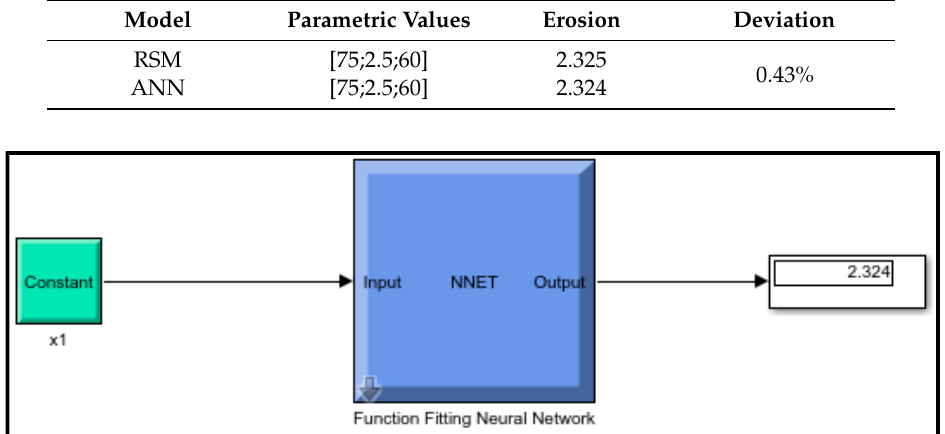
Table 5. Comparative analysis on response surface methodology (RSM) and artificial neural network (ANN).